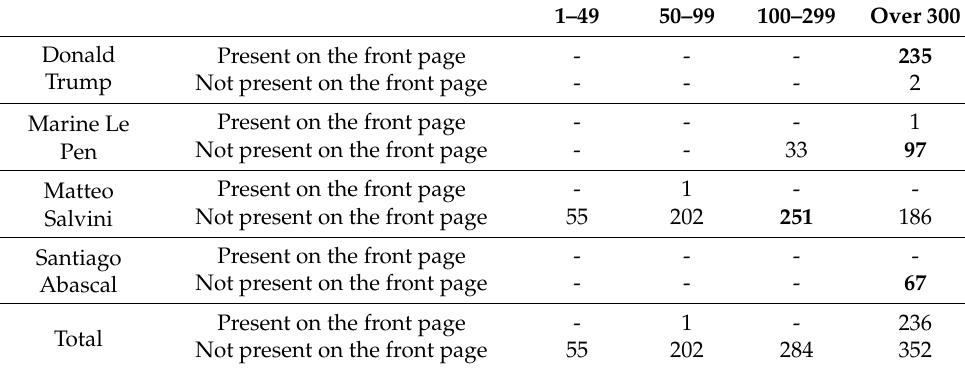
and number of retweets for messages on Twitter (%). Relevant findings are presented in